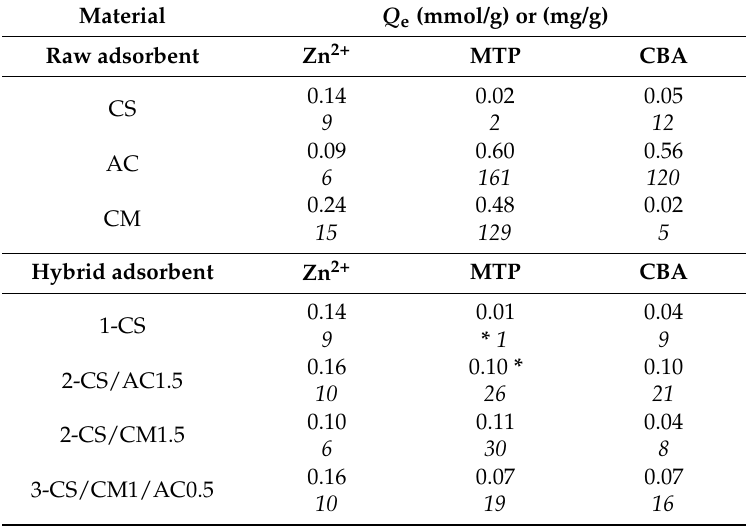
Figure 5. Charges of adsorbents and pollutants as a function of pH. The red line corresponds to the working pH value. Table 4. Maximum adsorbed amounts Q e calculated from adsorption kinetics of Zn 2+ , Metoprolol (MTP) and clofibric acid (CBA) using the second-order model, or the first-order model (*).